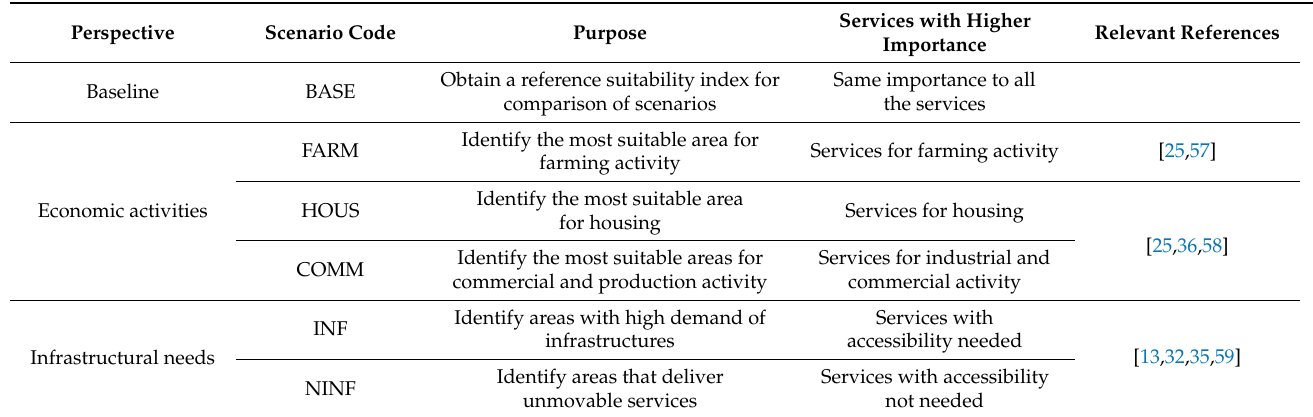
Table 2. Scenarios defined in this study for the SUSAM